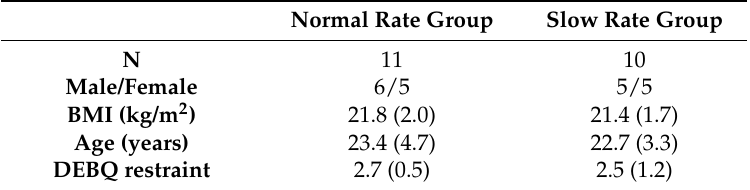
Table 1. Baseline characteristics of normal and slow rate groups. (mean; SD).